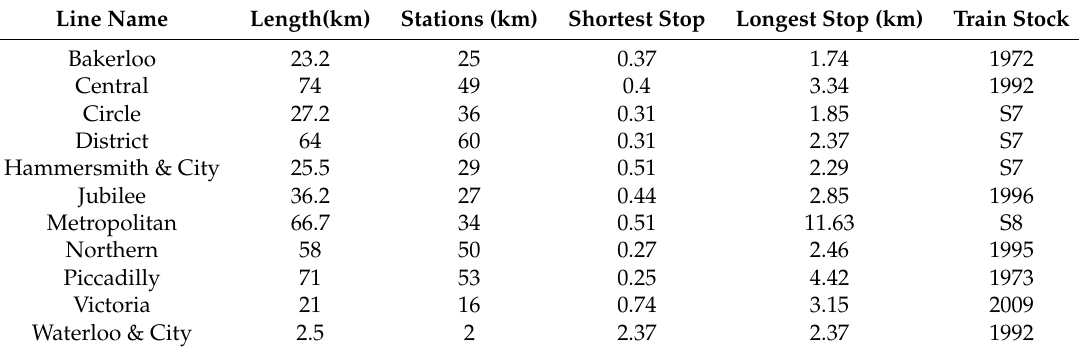
Table 1. An overview of 11 London underground lines sorted in alphabetical order that were surveyed in the training